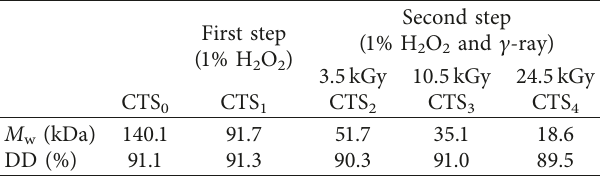
Table 1: Degradation of chitosan in the swollen state (first step) and in solution (second